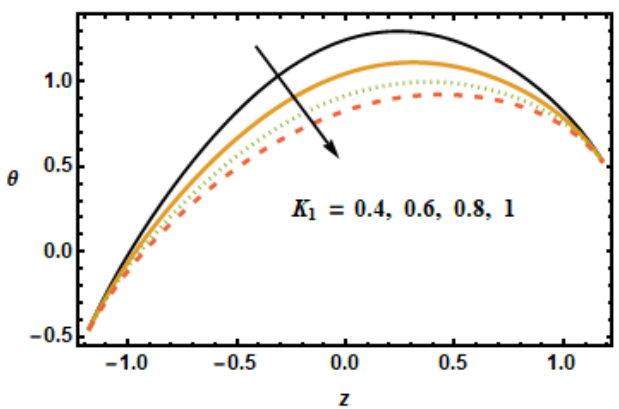
Figure 16. Dependence of θ on K 1 .